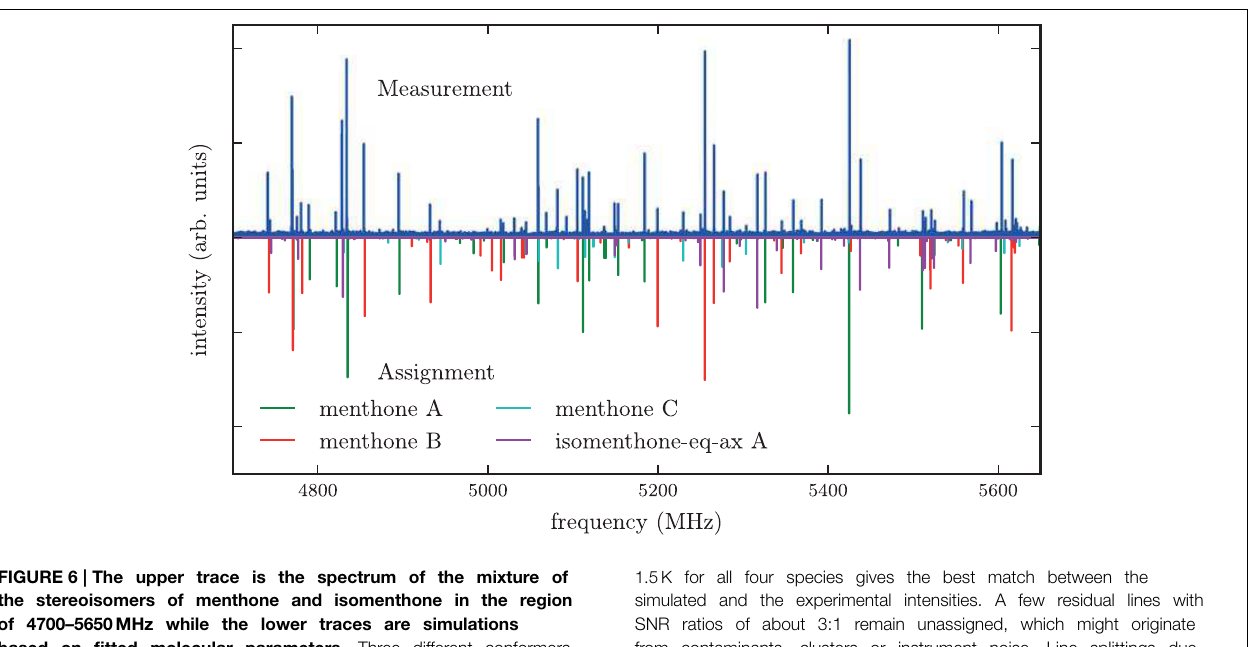
1 . 5K for all four species gives the best match between the simulated and the experimental intensities. A few residual lines with SNR ratios of about 3:1 remain unassigned, which might originate from contaminants, clusters or instrument noise. Line splittings due to internal rotation of one of the methyl groups of menthone or isomenthone were not observed.